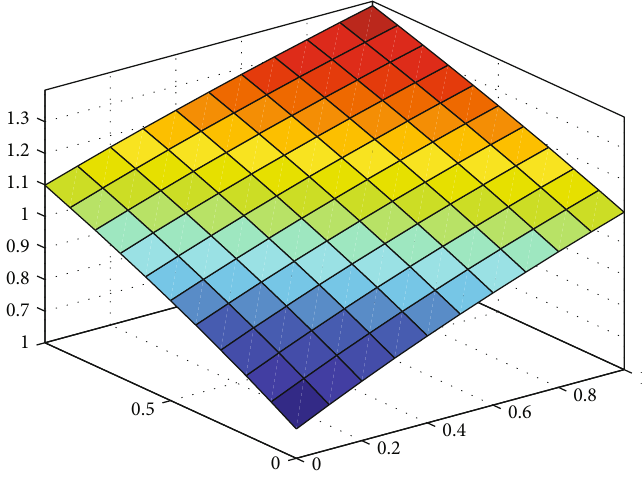
Figure 1: Analysis solutions of u ð x , t Þ = ln ð x + t + 2 Þ .